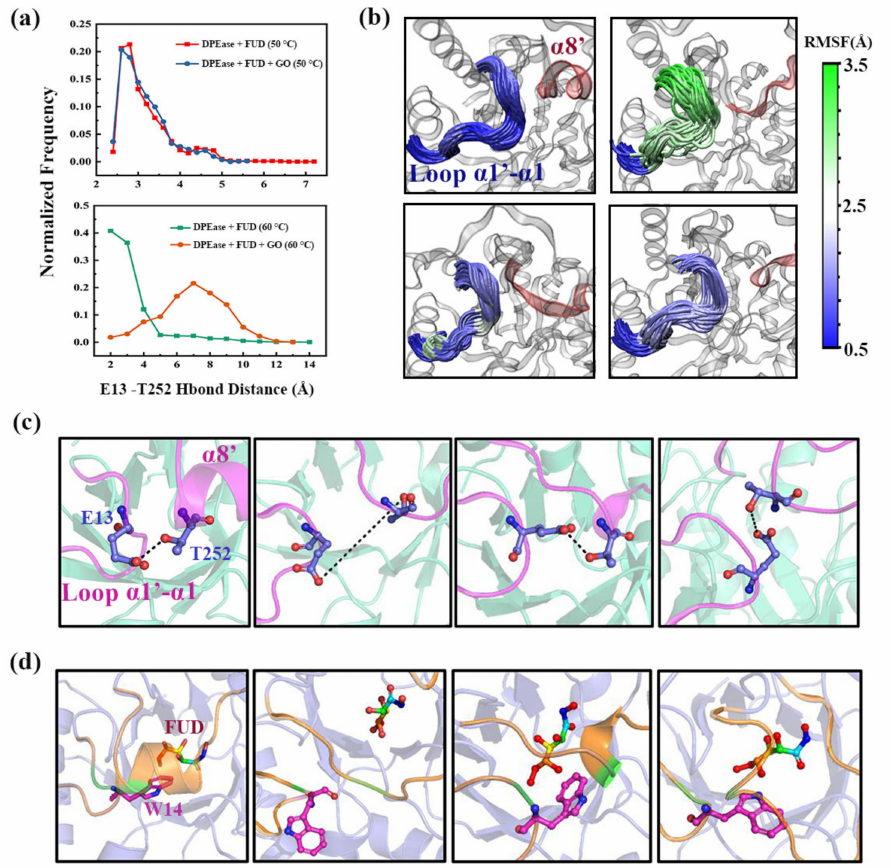
Figure 8. ( a ) Relative frequency of distance distribution for the 300 ns MD simulation; ( b ) loop α 1 (cid:48) - α 1 residues are colored mapped from green (most flexible) through white to blue (least flexible) according to their calculated C α RMSF; ( c ) representational structure diagram of the distance between E13 and T252; ( d ) representation snapshots of relative positions between W14 and FUD.